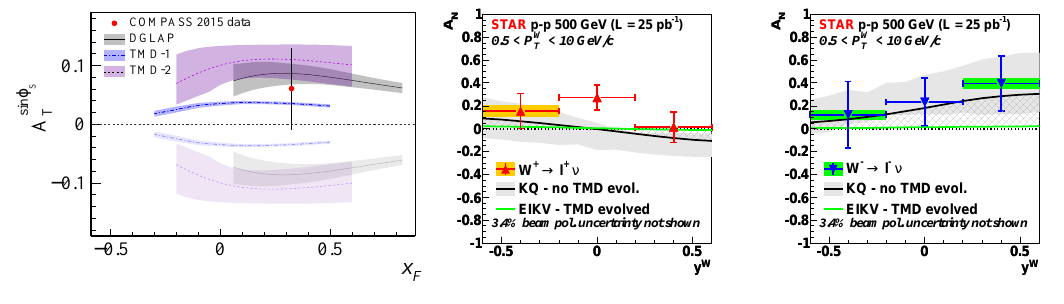
Fig. 6: The measured mean Sivers asymmetry and the theoretical predictions for different Q 2 evolution FIG. 3. [ Color online ] The amplitude of the transverse single-spin asymmetry for W ± and Z 0 boson production measured by schemes from Refs. [19] (DGLAP), [20] (TMD1) and [21] (TMD2). The dark-shaded (light-shaded) STAR in proton-proton collisions at √ s = 500 GeV with a recorded luminosity of 25 pb − 1 . The solid gray bands represent Figure 3: Left: COMPASS Sivers asymmetry amplitude from pion-induced DY on an the uncertainty on the KQ [11] model due to the unknown sea quark Sivers function. The crosshatched region indicates the predictions are evaluated with (without) the sign-change hypothesis. The error bar represents the total current uncertainty in the theoretical predictions due to TMD evolution. NH transversely polarized target [ 21 ] . The solid curves (DGLAP [ 22 ] , TMD-1 [ 23 ] , 3 experimental uncertainty. TMD-2 [ 24 ] ) are fits to SIDIS world data that include the Sivers sign switch. Right: fits to experimental data. A consensus on how to obtain and handle the non-perturbative input in the TMD evo- left-right asymmetry A in W -boson production from p ↑ p collisions at STAR [ 25 ] . N lution has not yet been reached [27]; therefore the results presented here can help to constrain theoretical models. A combined fit on W + and W − asymmetries, A N ( y W ), apparatus and in overlapping kinematic domains. STAR measured left-right asymmetries in to the theoretical prediction in the KQ model (no TMD (cid:112) evolution), shown in Fig. 4, gives a χ 2 /ndf = 7 . 4 / 6 as- W - and Z -boson production from p ↑ p collisions at s = 500 GeV RHIC energies [ 25 ] . suming a sign-change in the Sivers function ( solid line ) and a χ 2 /ndf = 19 . 6 / 6 otherwise ( dashed line ). The cur- rent data thus favor theoretical models that include a change of sign for the Sivers function relative to observa- tions in SIDIS measurements, if TMD evolution effects are small.